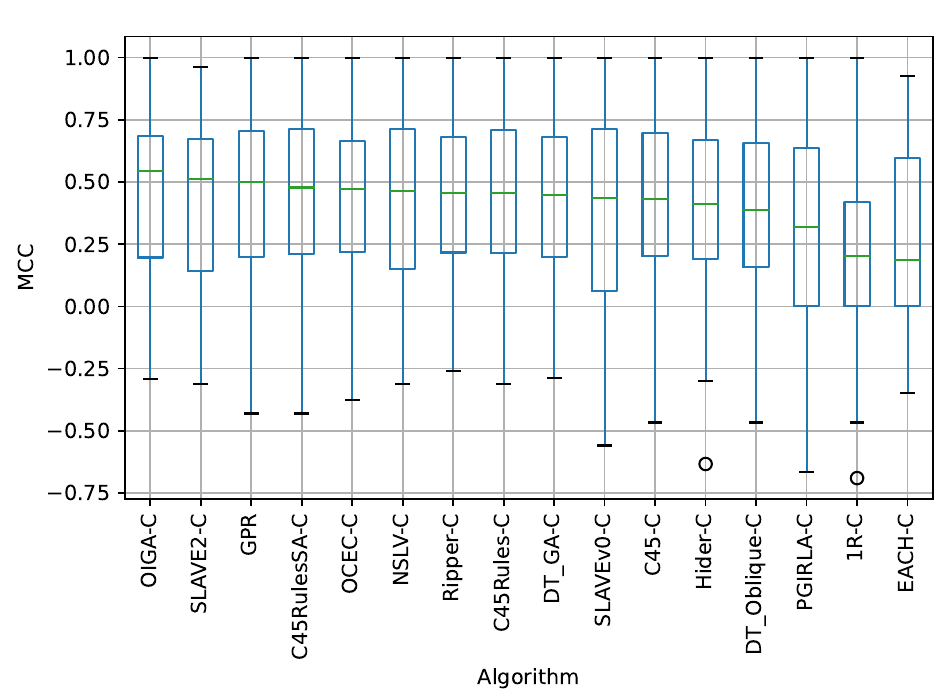
Algorithm−0.75−0.50−0.250.000.250.500.751.00 Figure 1. Distribution of the MCC values for each algorithm in all datasets. Figure 2. Distribution of the AUC values for each algorithm in all